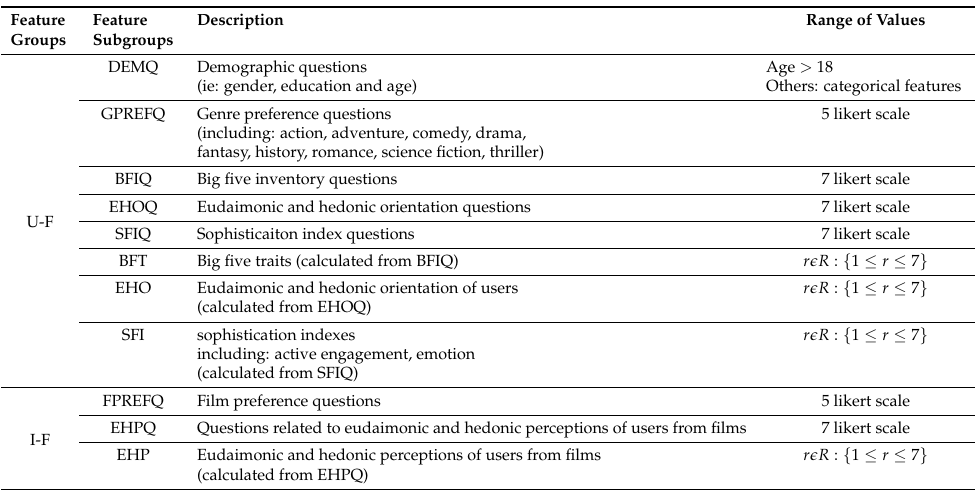
Table 1. Feature list. Answers to the question sets provided to users are represented by feature groups ending in Q. BFT, EHO and SFI were calculated based on user responses. The features that describe users and interactions are U-F and I-F, respectively.